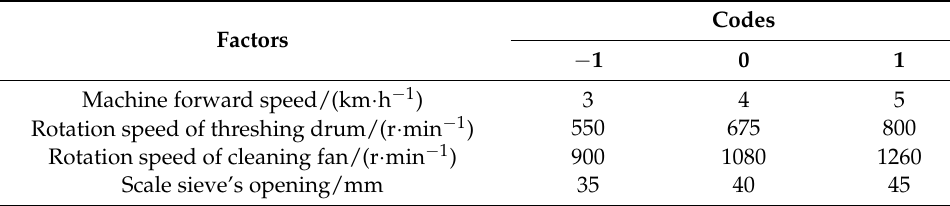
Table 4. Experiment factors and codes.